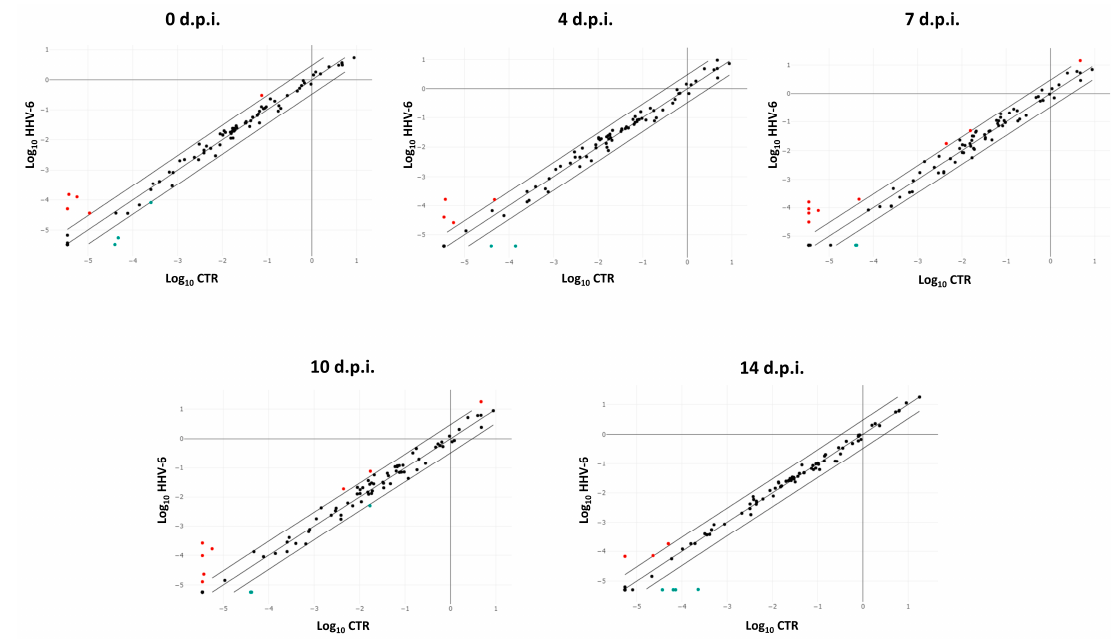
Figure 3. Scatterplot representation of the fibrosis-associated factors altered by human herpesvirus 6A (HHV-6A) infection in primary human dermal fibroblasts. At each time p.i. (d.p.i. = days post-infection), cell samples were collected and analyzed by specific qPCR microarray. The significance threshold was put at 3-fold expression change in infected vs. uninfected control cells. Red dots: upregulated factors; blue dots: downregulated factors; black dots: not significantly altered factors. Results represent mean values of duplicate samples from two independent experiments, and are expressed in logarithmic scale (Log 10 HHV-6 = logarithmic values in HHV-6A-infected cells; Log 10 CTR = logarithmic values in control uninfected